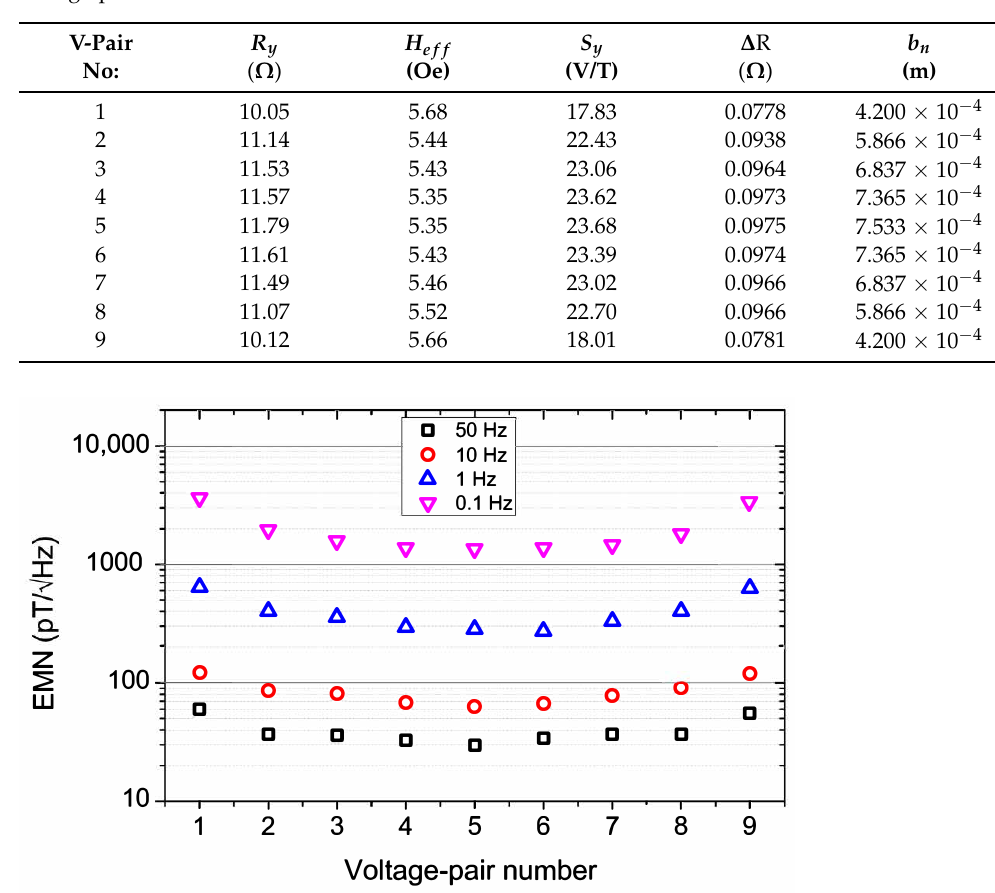
Table 1. Typical values of R y , H ef f , S y (for I x = ∼ 130 mA (peak)), ∆ R, and b n for different parallel voltage-pairs of EPHEG.